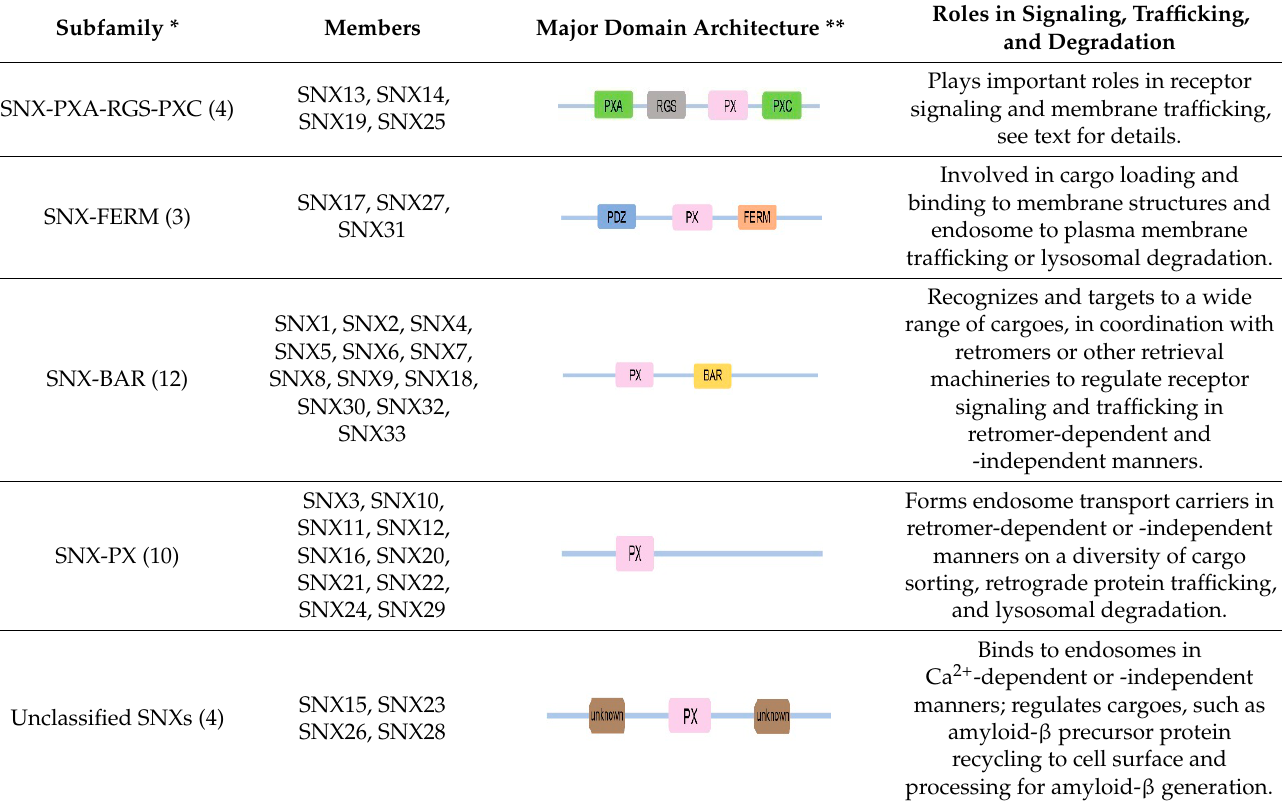
Table 1. Summary of mammalian sorting nexin (SNX) subfamilies [5–8].